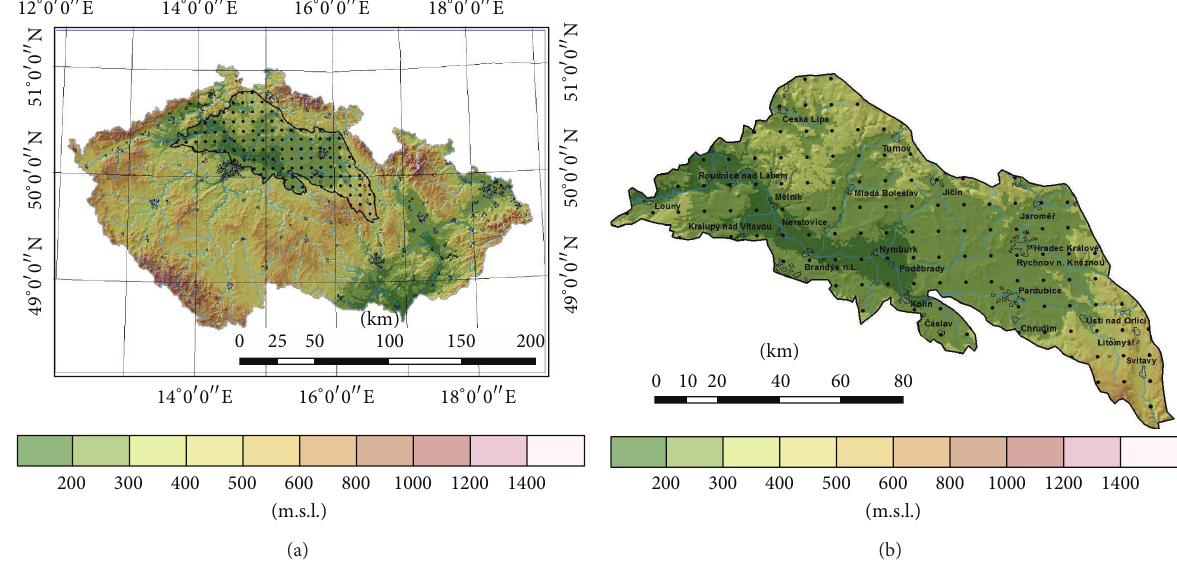
Figure 1: The boundaries of Elbe River lowland in the Czech Republic and location of the 116 grid points and their elevation (m a.s.l.) in the Elbe River lowland (a) and the relief map of Elbe River lowland